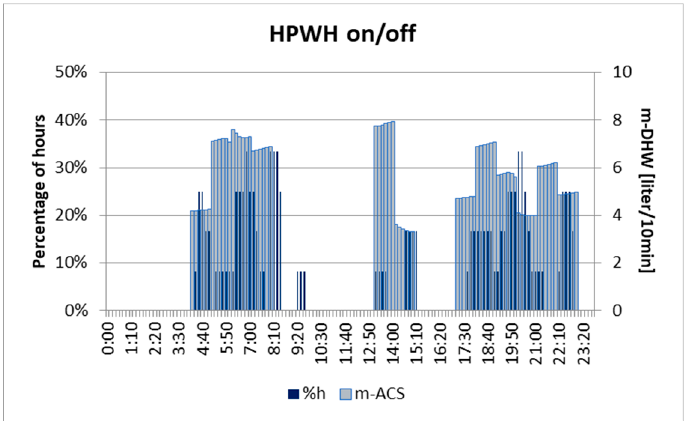
Figure 11. Percentage of time that the HPWH was “on” in an hour during the year with respect to the adopted tapping profile.